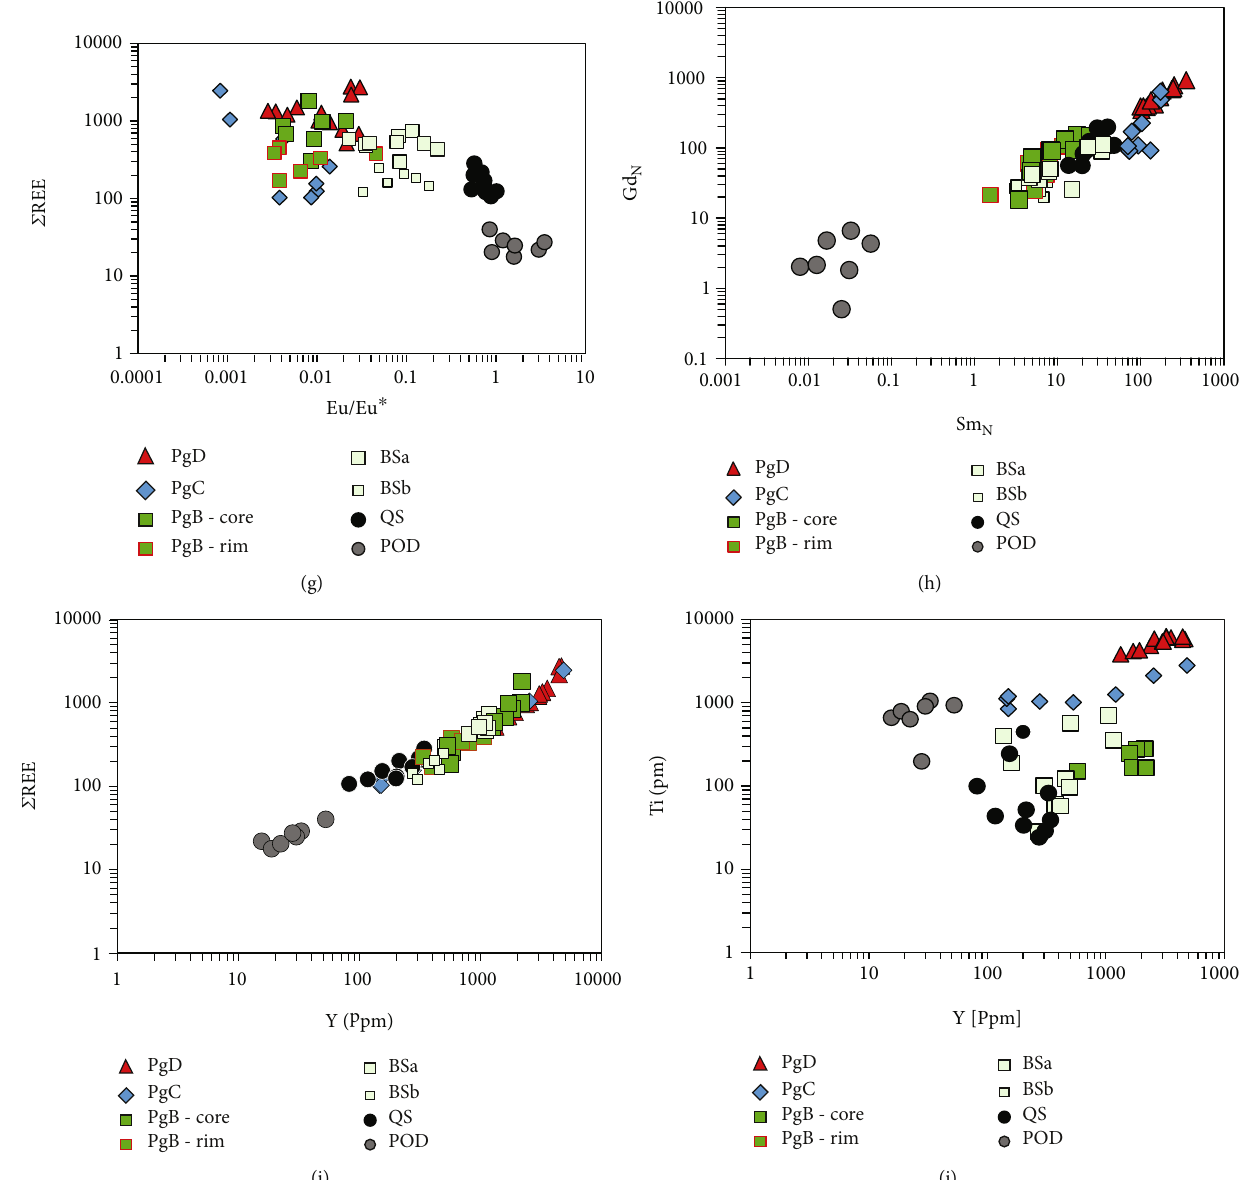
Figure 7: Chondrite-normalized rare earth element (REE) patterns of garnet. (a) PgD, (b) PgC, (c) PgB, (d) BS, (e) QS, and (f) POD. The core compositions are generally more REE enriched than the rim compositions. For the BS, di ff erent samples are shown. La to Sm and Gd to Lu are referred to as the light and heavy REEs, respectively. (g) Eu/Eu ∗ versus total REE contents. (h) Sm chondrite-normalized concentrations of Sm and Gm, respectively. (i) Y versus total REE contents. (j) Y versus Ti. Chondrite-normalizing values are from Taylor and McLennan [39]. Note that the x -axis scale varies in (g –